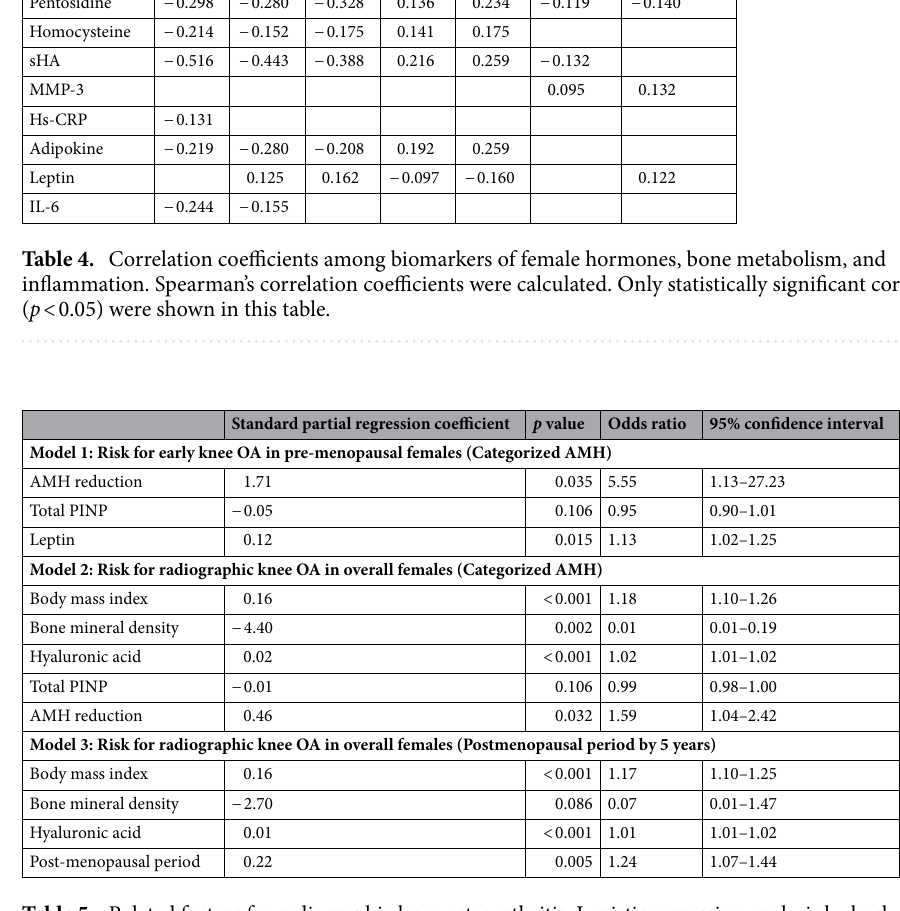
Table 5. Related factors for radiographic knee osteoarthritis. Logistic regression analysis by backward stepwise selection method was performed, with the presence of early knee osteoarthritis or knee osteoarthritis as dependent variable, and body mass index, bone mineral density, bone metabolic markers, and inflammation markers as independent variables. Furthermore, model 1 and 2 included categorized anti-Mullerian hormone (AMH) reduction (pre-menopause with AMH ≥ 0.08, pre-menopause with AMH < 0.08, or post-menopause). Model 3 included post-menopausal period by 5 years after menopause.